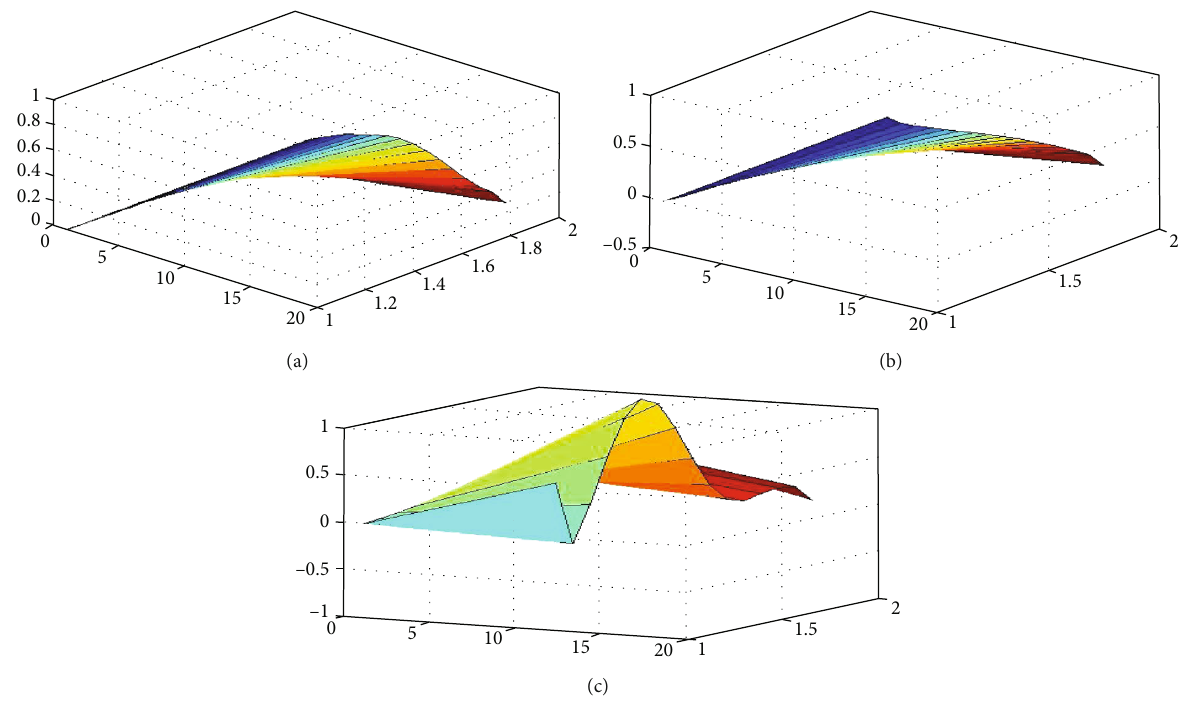
Figure 11: (a – c) Mode shapes of cross-ply annular circular plate ( U ).